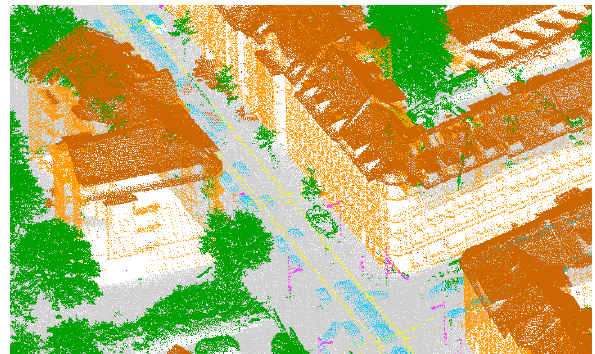
Figure 7 . Close-up view of classification results generated with KPConv using prior